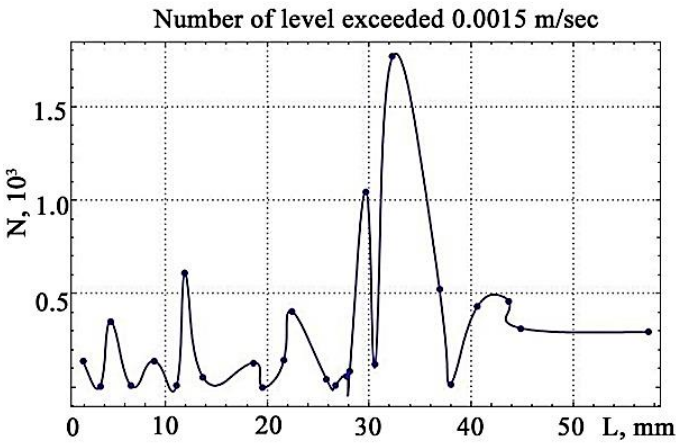
Figure 16. The visualisation of the number of excesses of vibration signals over the levels of